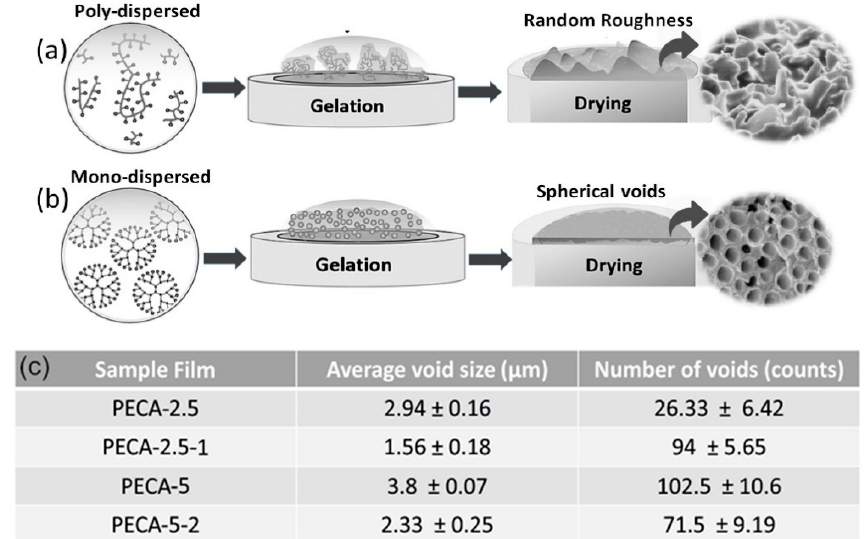
Figure 3. ( a ) Schematic description of poly-dispersed and ( b ) monodispersed polymer solution drying and formation of surface roughness features. ( c ) Tabulated average surface void size (diameter) and the number of surface voids of all PECA–PPC blends studied. All data are collected from a SEM viewing window of 132 × 90 microns and represented as mean ± SD (standard deviation) of three measurements.